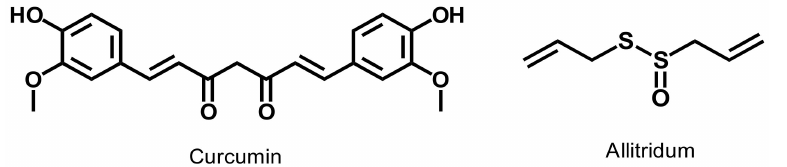
Figure 2. Chemical structures of curcumin and allitridum, natural substances evaluated for their spermicidal